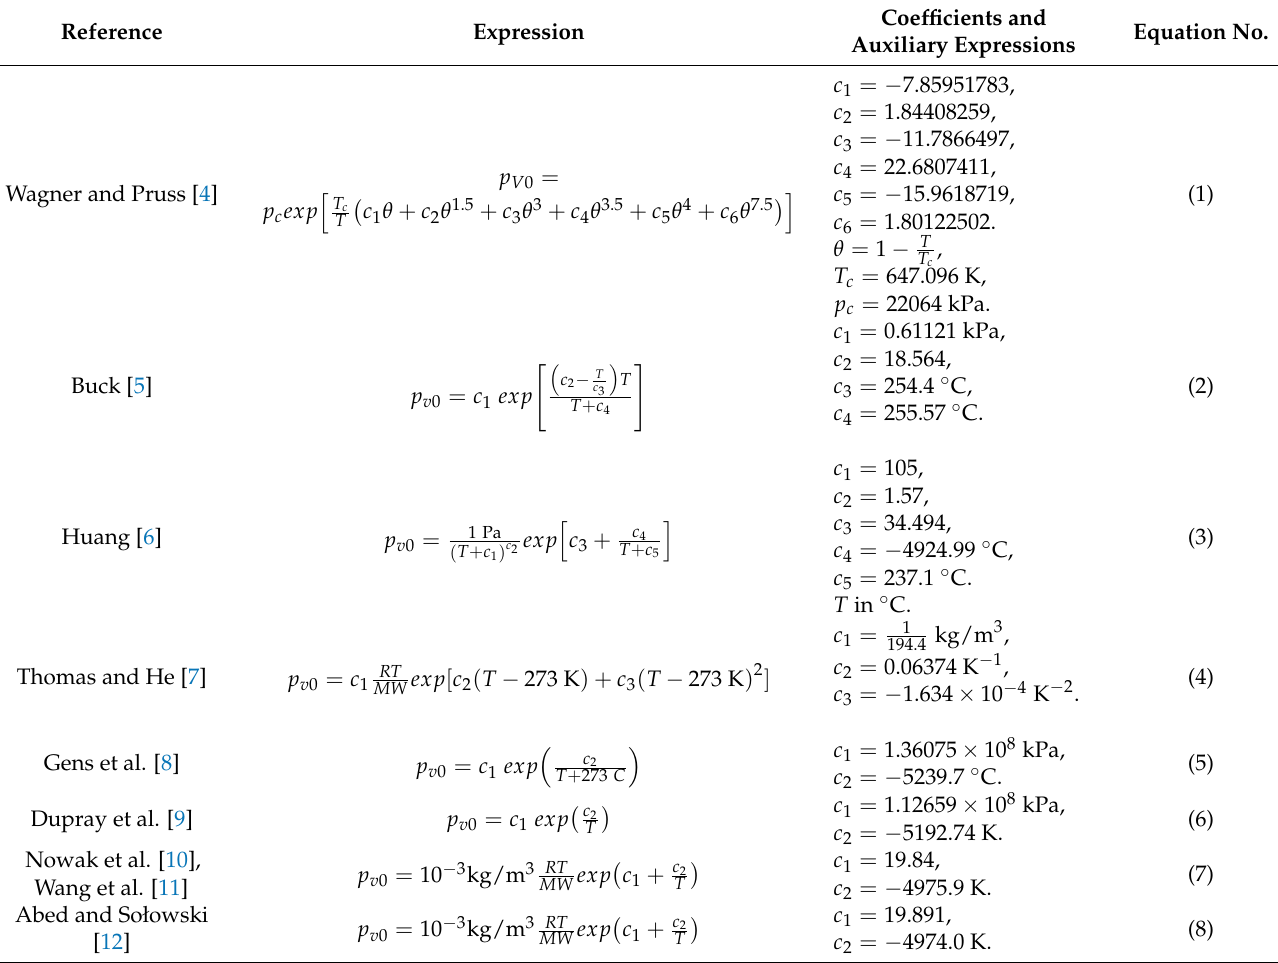
Table 1. Expressions for saturated water vapour pressure as a function of temperature T from